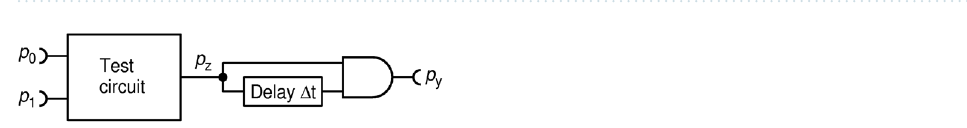
Figure 23. The comparator circuit (a) and its transfer functions for various counter bit-lengths (b) .